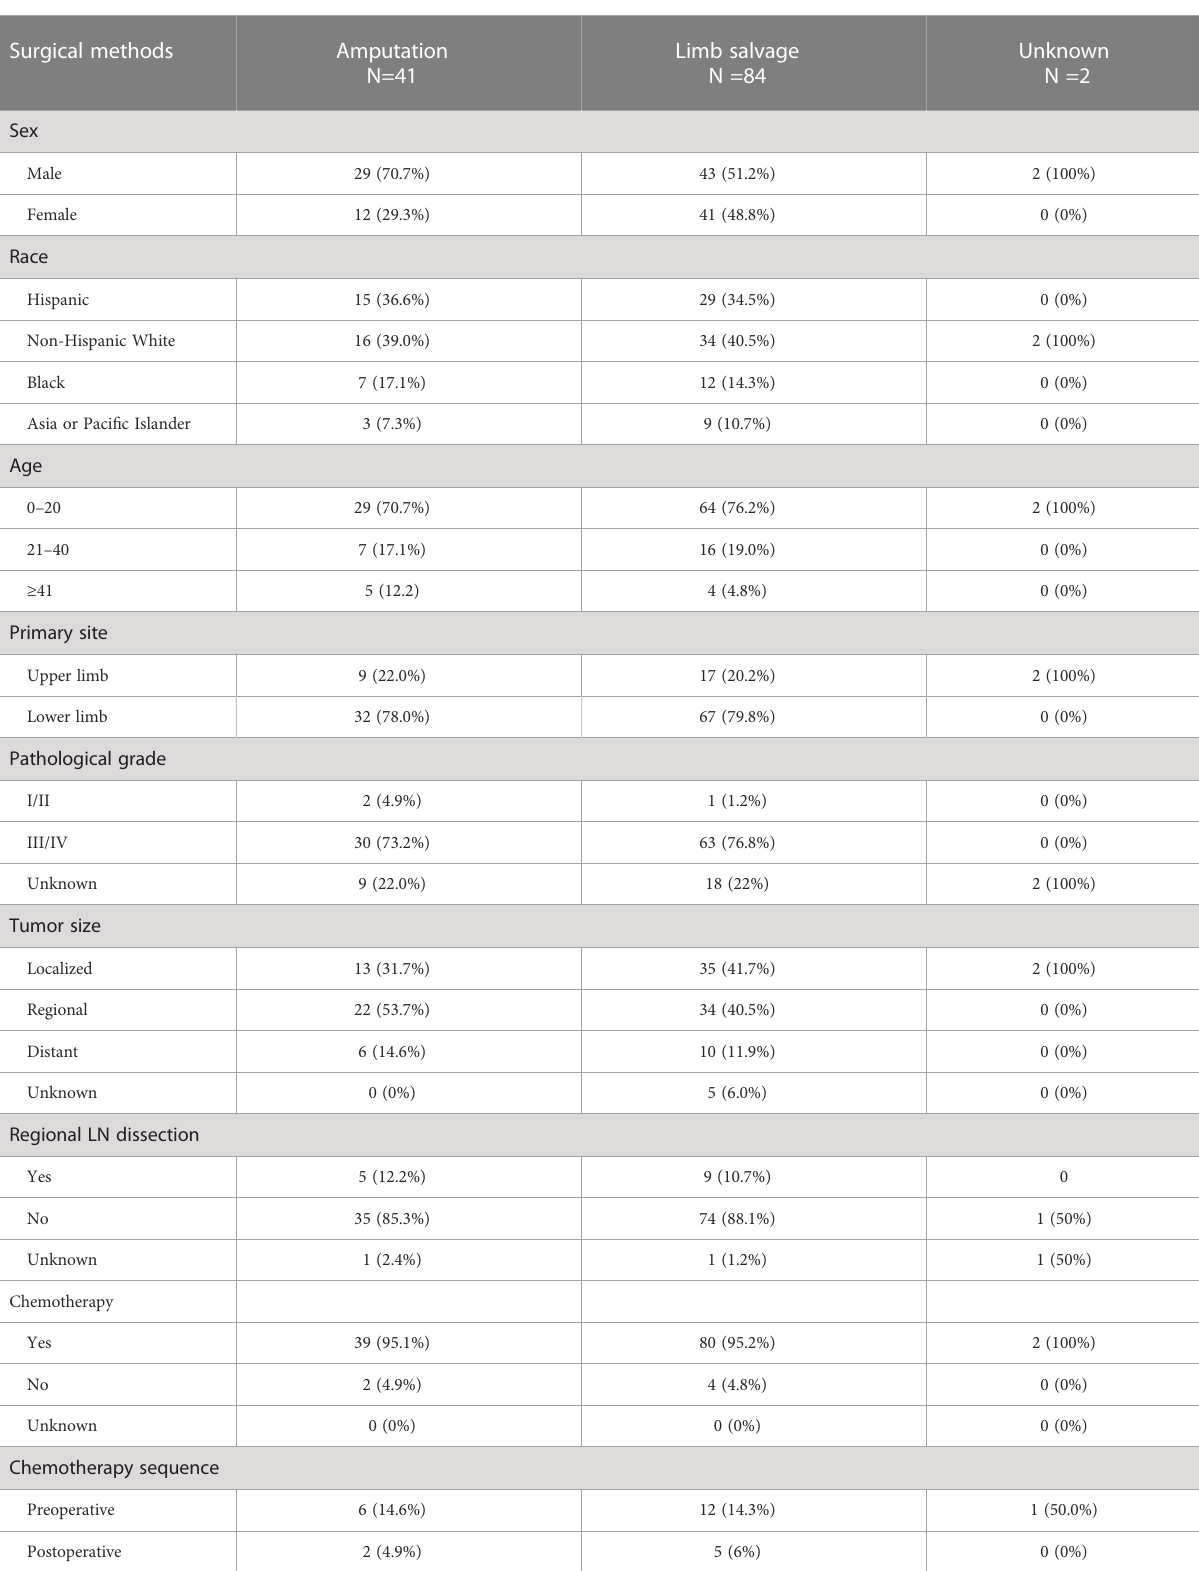
TABLE 1 Patient characteristics by surgical